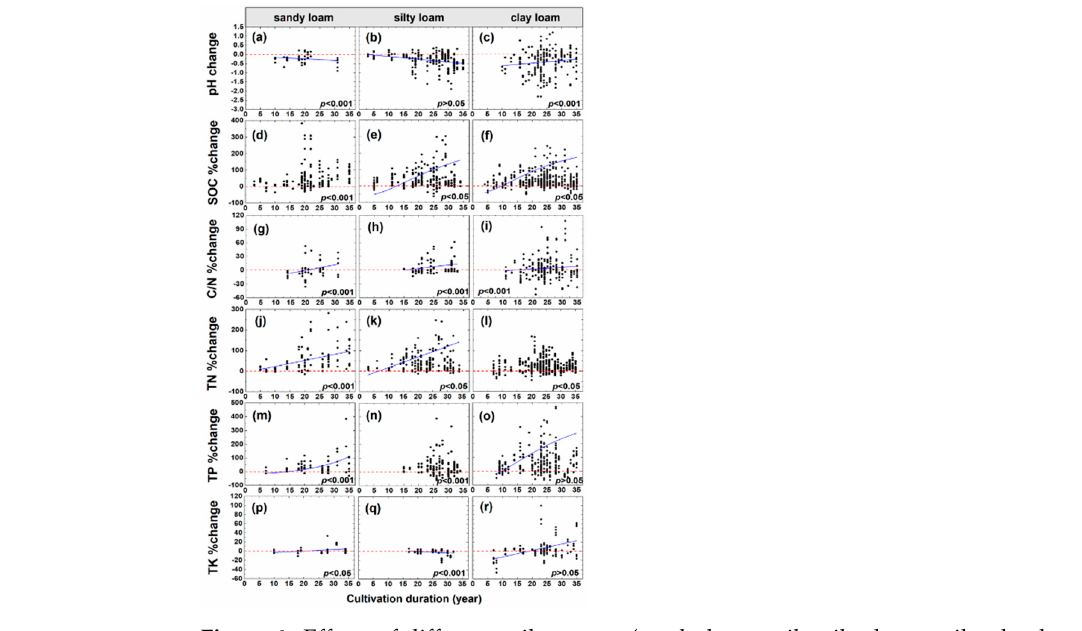
Figure 6. Effects of different soil textures (sandy loam soils, silty loam soils, clay loam soils) on soil chemical properties (pH ( a – c ), SOC ( d – f ), C/N ( g – i ), TN ( j – l ), TP ( m – o ) and TK ( p – r )) with the cultivation duration (SOC: soil organic carbon, C/N: organic carbon − nitrogen ratio, TN: total nitrogen, TP: total phosphorus, TK: total potassium). Change and % change were compared to the control. Table 1. Spearman’s rank correlation coefficients between the responses of soil chemical properties and the explanatory variables (MAP, MAT, cultivation duration and